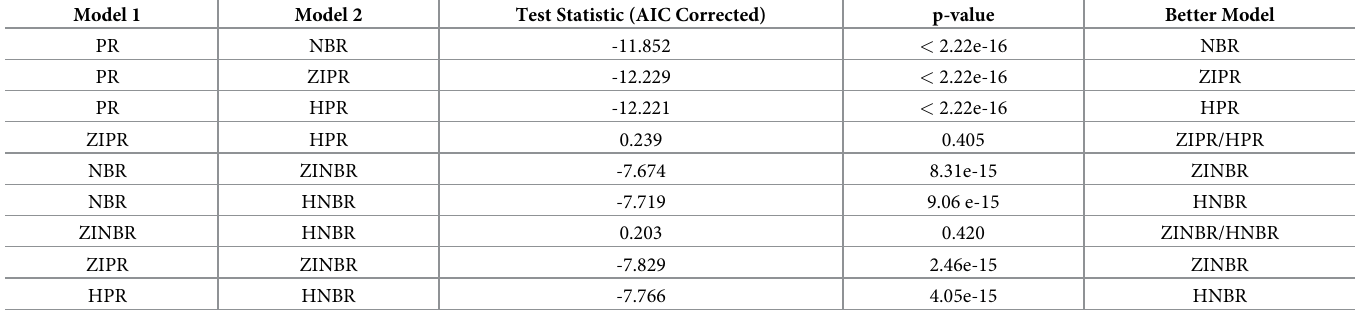
Table 3. Vuong Tests for the non-nested models Poisson regression (PR), negative-binomial regression (NBR), zero-inflated PR (ZIPR), hurdle PR (HPR), zero- inflated NBR (ZINBR), and hurdle NBR (HNBR) models.